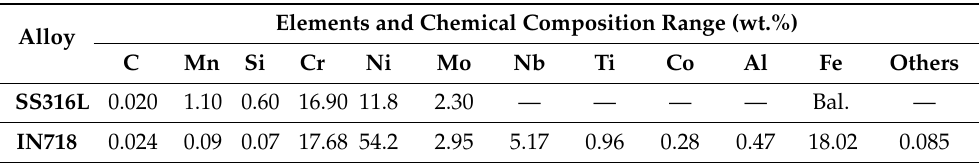
Table 1. Chemical composition of SS316L and IN718 powders used in LMD process (measured by TLS Technik).